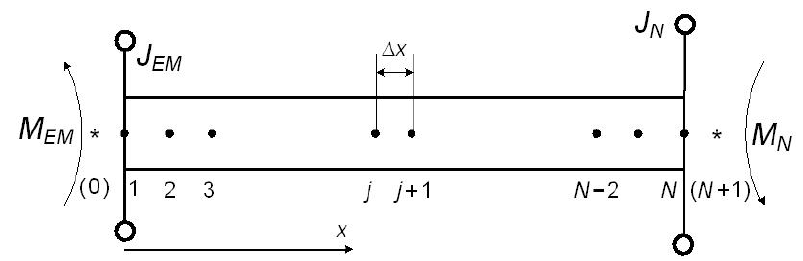
Figure 1. Long motion transmission shaft of electric drive.